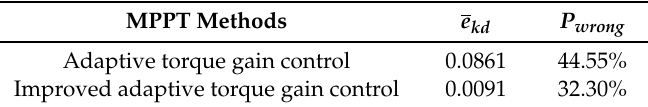
Table 5. Statistical results of incorrect searching.